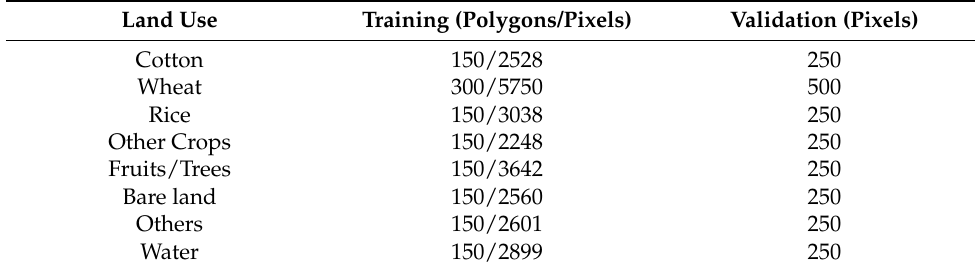
Figure 2. Location of training and ground-truthing samples. Table 3. Numerical information on training and validation